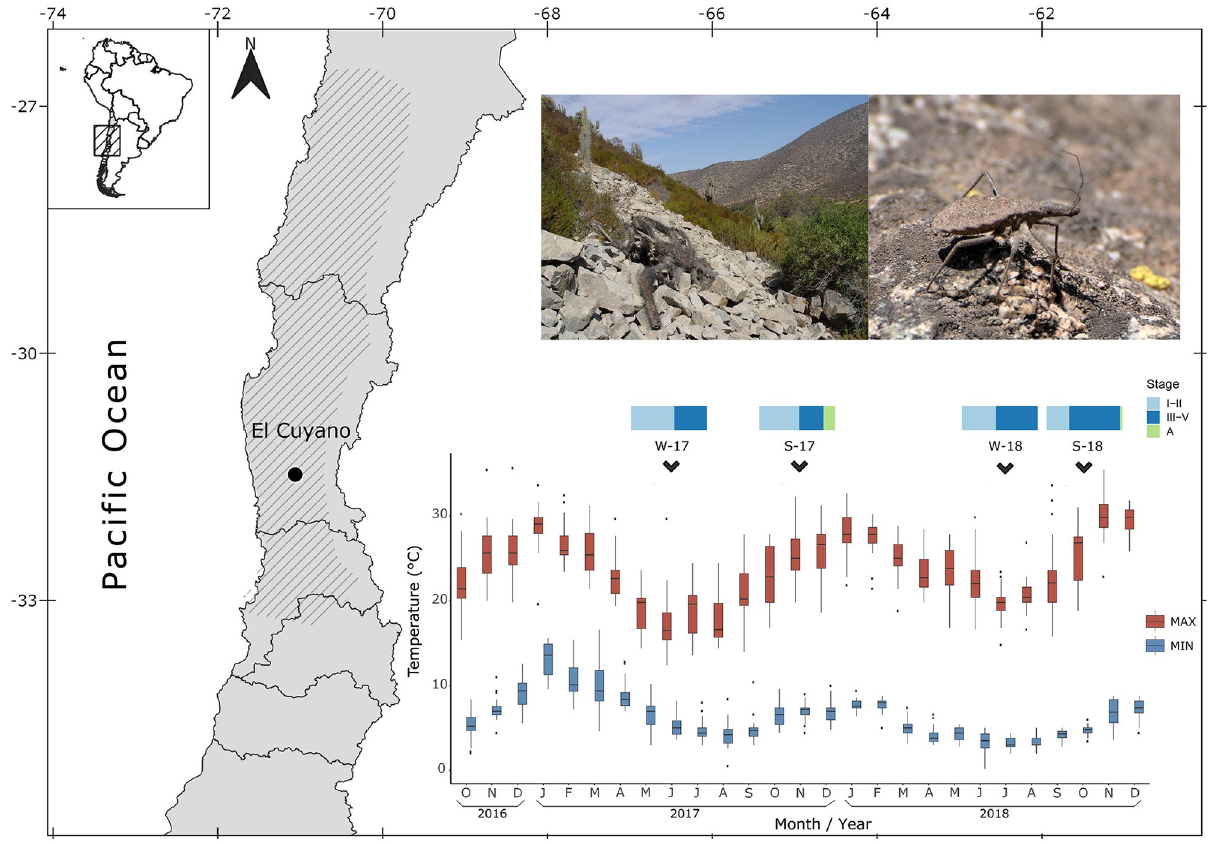
Fig 1. Study site and environmental temperatures. Map of North-central Chile showing in hatch pattern the distribution of Mepraia spinolai and the study site, El Cuyano (left). Photographs of the rocky outcrop where M . spinolai are collected and a late stage nymph of M . spinolai (top right). Boxplot of minimum (blue boxes) and maximum (red boxes) temperatures from October 2016 to December 2018, indicating the capturing month of the four groups of M . spinolai under study: winter and spring 2017 (W-17, S-17) and 2018 (W-18, S-18) (bottom right). The proportion of collected bugs per development stage is shown for each capture event: early (I and II) and late (III, IV, and V) stage nymphs, and adults (A). Photos by Carezza Botto- Mahan. Base layer of the map available at https://www.ide.cl/index.php/informacion-territorial/descargar-informacion-territorial.